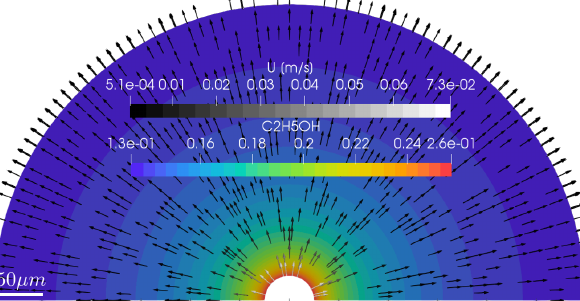
Figure 10. Velocity vectors overlaid on the contours of mass fraction of ethanol at 1 ms for pulsed